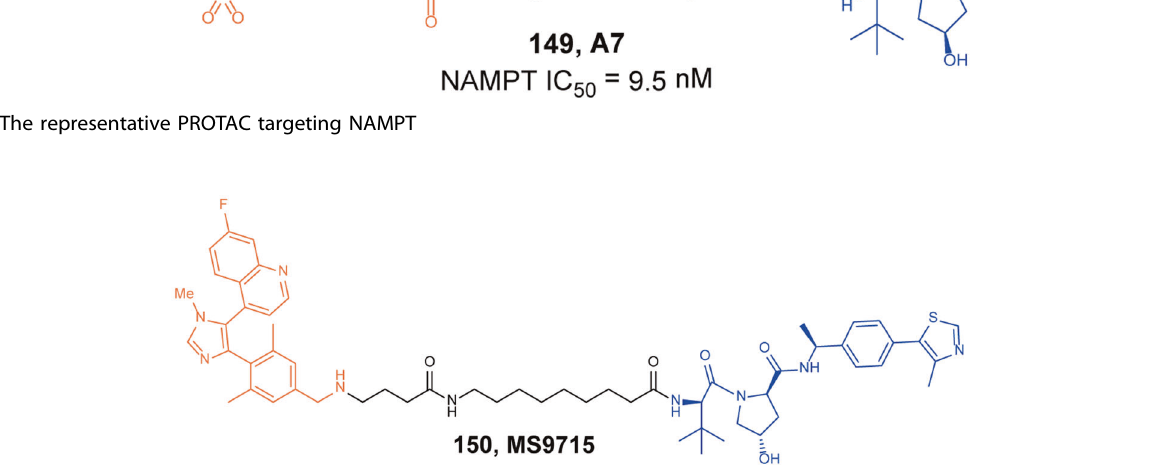
Fig. 36 The representative PROTAC targeting NSD3 Signal Transduction and Targeted Therapy (2022)